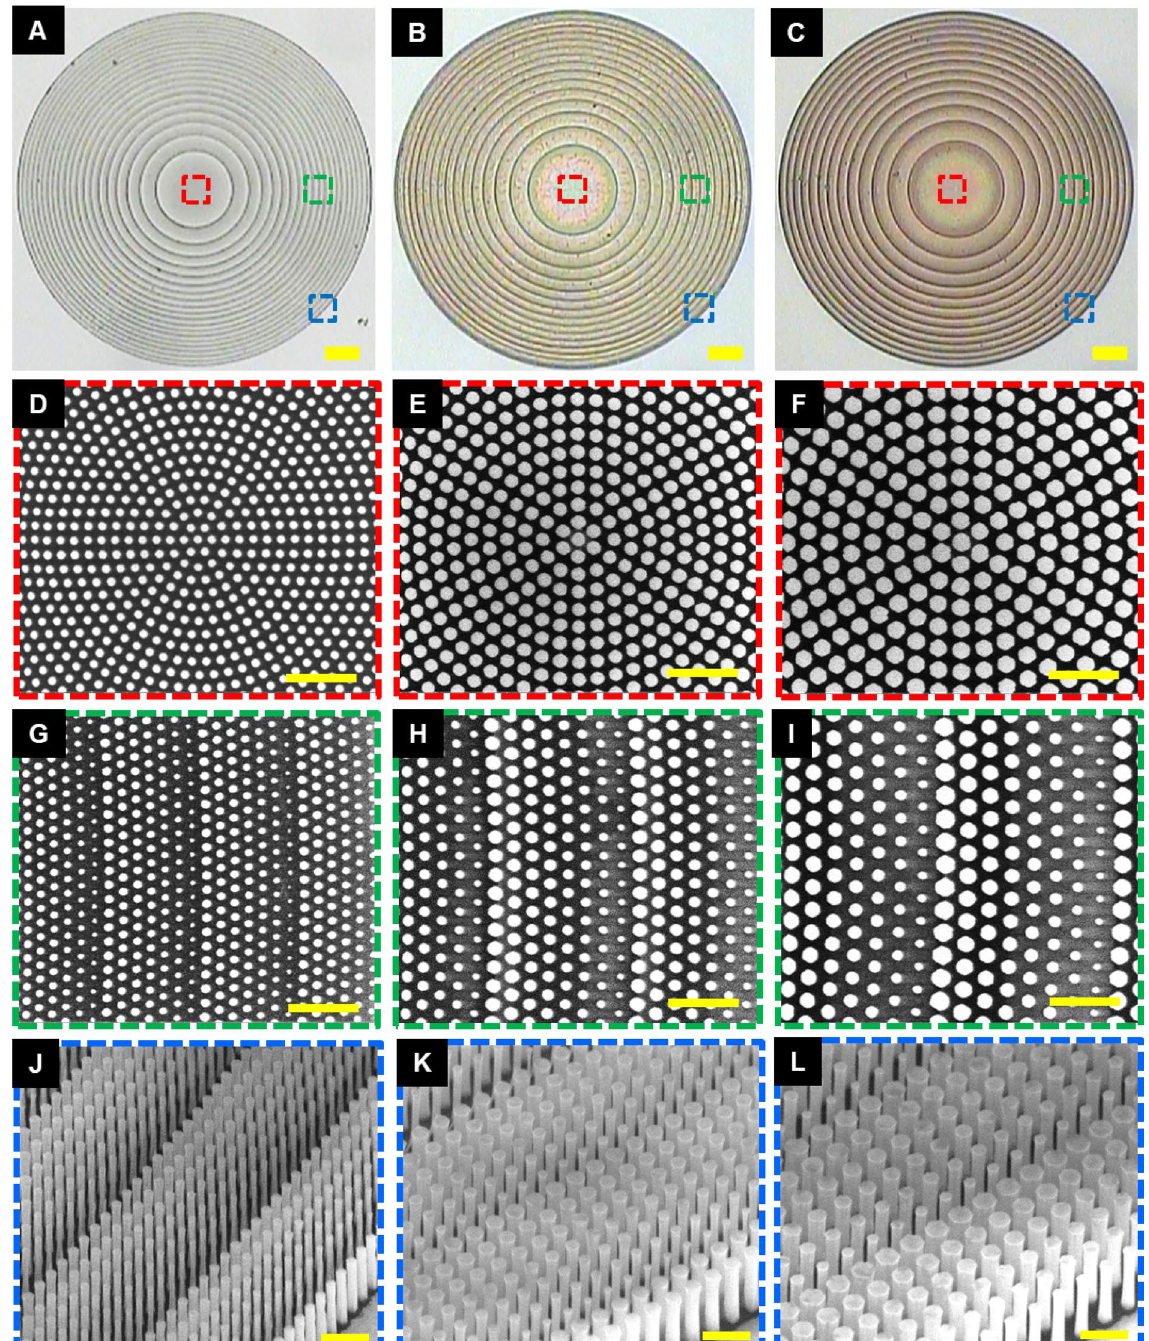
Figure 2. Micrographs of the metalenses. ( A – C ) Optical images of the fabricated metalenses designed at wavelengths of ( A ) 405, ( B ) 532, and ( C ) 633 nm. Scale bar: 10 μm. ( D – I ) The top-view SEM images shown in ( D , G ), ( E , H ), and ( F , I ) corresponding to the highlighted regions in ( A – C ). Scale bar, 2 μm in ( D – I ). ( J – L ) The tilt-view SEM images shown in ( J – L ) corresponding to the highlighted regions in ( A – C ). Scale bar, 1 μm in ( J – L